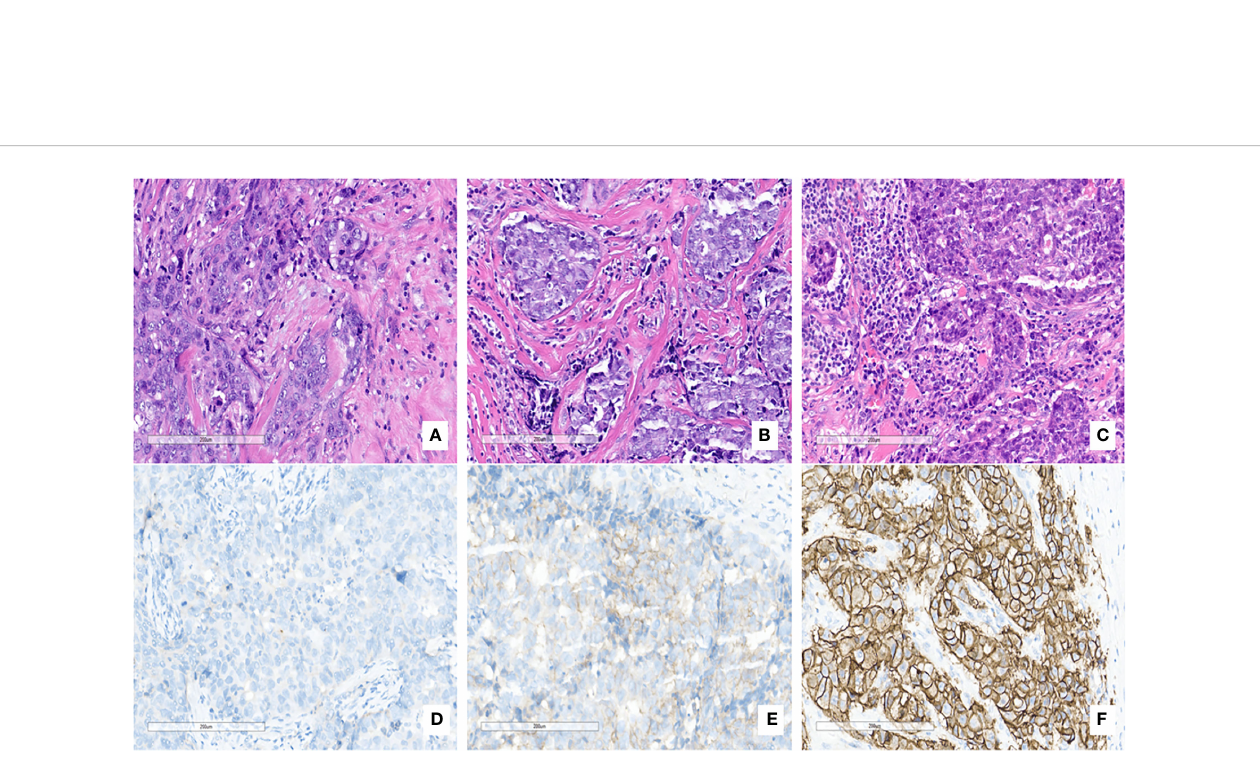
FIGURE 7 Different expressions of sTILs [ (A) Low, (B) intermediate, (C) high] and different expression levels of Her2 [ (D) IHC 0, (E) IHC 1+, (F) IHC 2+/FISH-negative] were detected in tumors by using hematoxylin and eosin staining